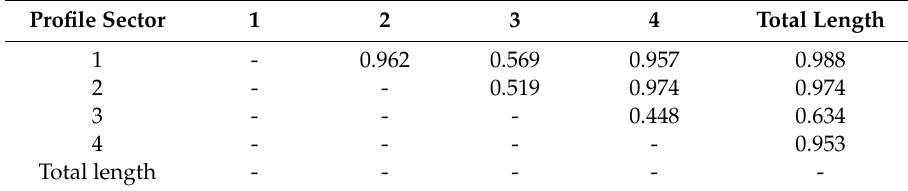
Table 3. Correlation between correlation